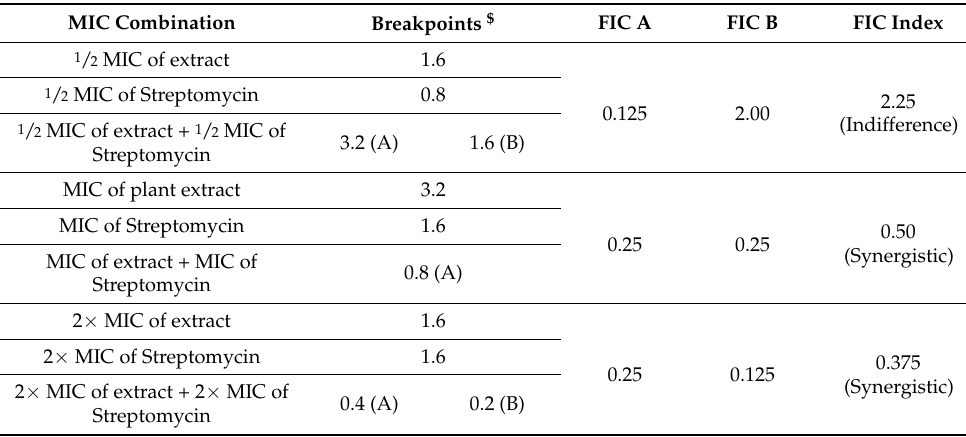
Table 4. FIC values and FIC index of antibiotic and plant extract.